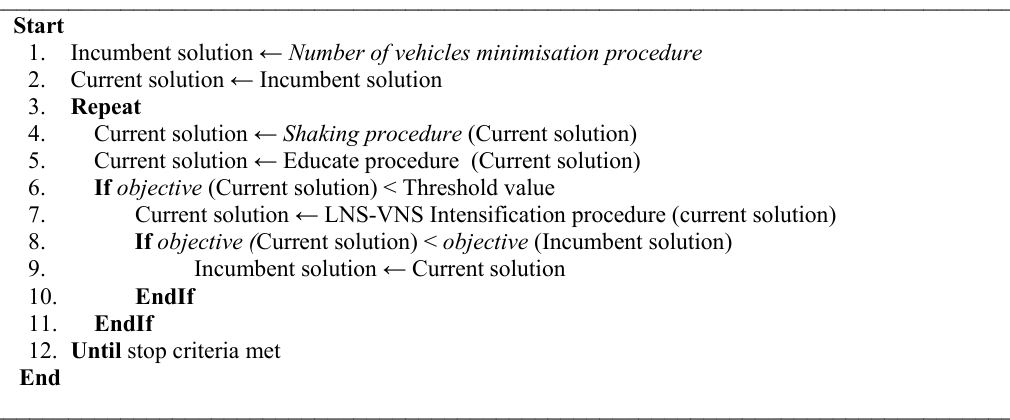
Algorithm 3: Travel time and travel distance minimisation